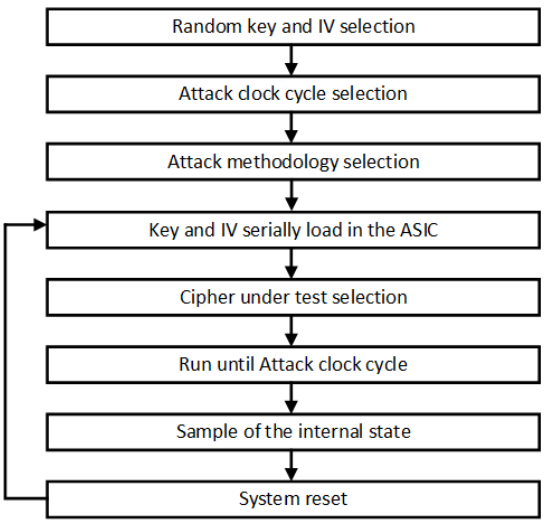
Figure 12. Representation of the attack